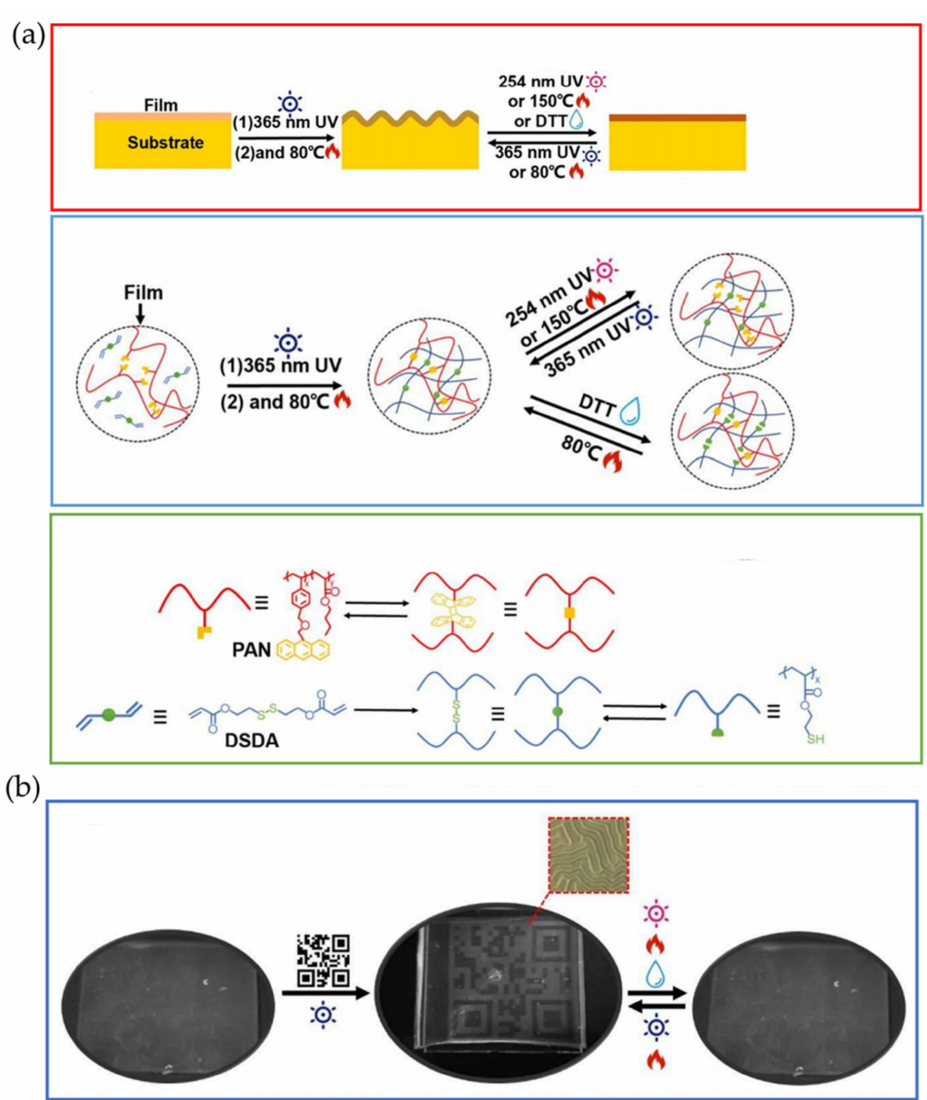
Figure 38. ( a ) Schematic diagram of the IPN fabrication and transformation process and the corre- sponding wrinkle generation/quenching process. Bilayer wrinkle generation/quenching process (red). IPN formation/quenching in the film by multi-stimuli (blue). The reversible chemical reaction of PAN and DSDA in the skin layer (green). ( b ) Photography of QR code with the reversible wrinkled pattern. This pattern was fabricated using UV irradiation of 365 nm and erased using 254 nm in the UV range. Reproduced with permission from reference [152]. Copyright 2019, American Chemical Society